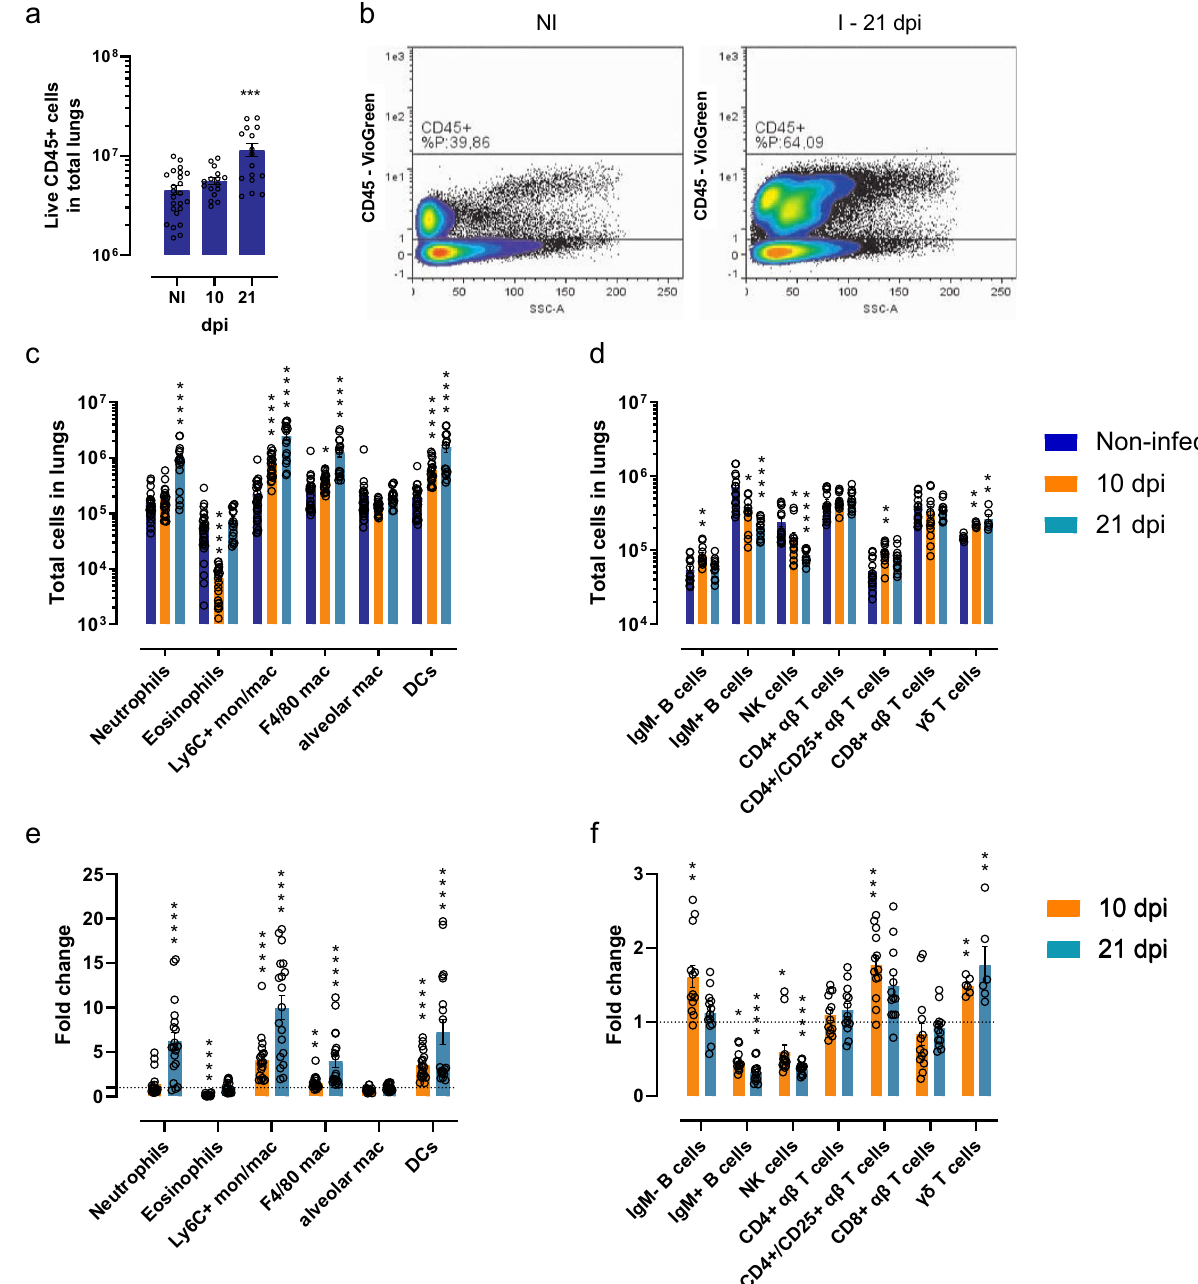
Fig. 4 | Immune cell composition of lung tissue of T. b. brucei infected mice. Groups of three to fi ve C57BL/6JRj mice were infected via the bite of a T. b. brucei AnTar1infected G.morsitans tsetse fl y. Three micewereprocessed as non-infected controls. After perfusion of the vascular system at 10 and 21 dpi, lung tissue was collectedandhomogenizedtoobtainsingle-cellsuspensions.Thegraphsrepresent a the total number of live CD45 + cells in the lungs (total number of animals: NI: n =12, 10 dpi: n =8, 21 dpi: n =8 examined over three independent experiments), b fl ow cytometry dot plots illustrating the percentage of CD45 + cells in naive (NI) and21dpimice,thetotalnumberof c myeloidand d lymphoidcellsinthelungsand e , f thefoldchangecomparedtonon-infectedcontrolmicecalculatedbasedonthe absolute cellnumbers. c , e Totalnumberofanimals: NI: n =15,10dpi: n =11,21dpi: